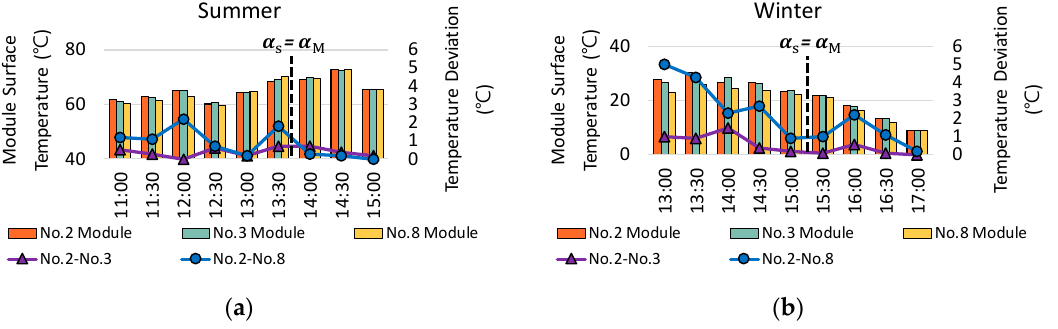
Figure 8. Module surface temperature comparison for the modules in the summer and winter: ( a ) module surface temperatures on 6 August; ( b ) module surface temperature on 26 January.